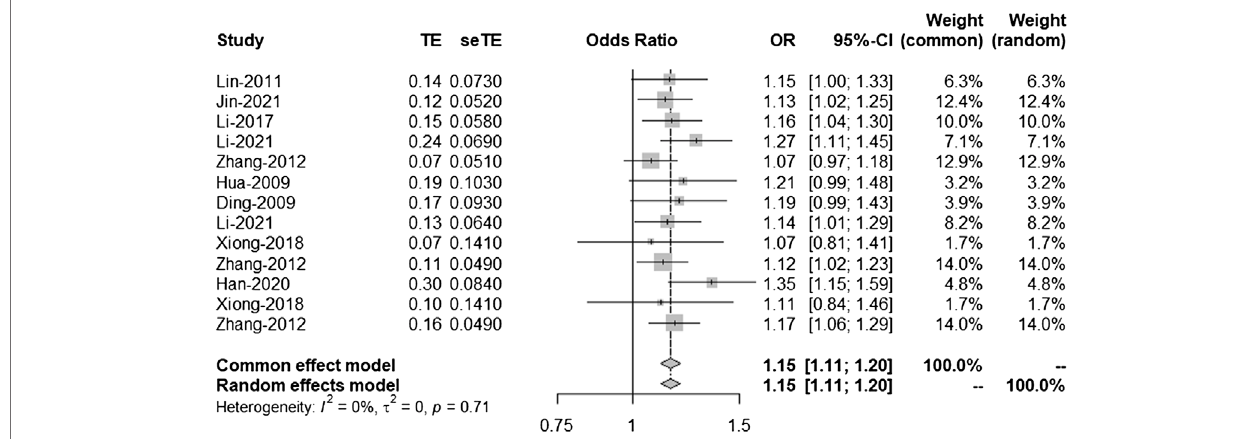
FIGURE 6 | Fixed-effects meta-analysis of the associated between the three single-nucleotide polymorphisms (SNPs; rs2383207, rs2383206, and rs10757278) and ischemic stroke (IS) in the third analysis. CI, con fi dence interval; OR, odds ratios.